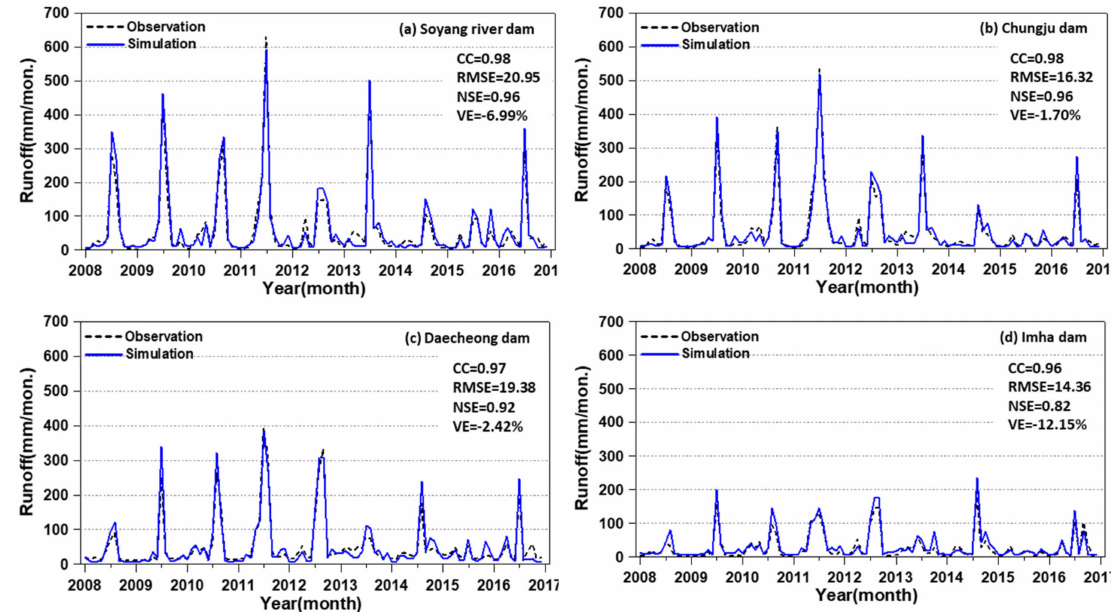
Figure 5. Simulated inflows of land surface models (LSMs) for the Soyang river ( a ), Chungju ( b) , Daecheong ( c ) and Imha ( d ) dams. The black dot lines and blue lines indicate the observation runo ff and simulation runo ff